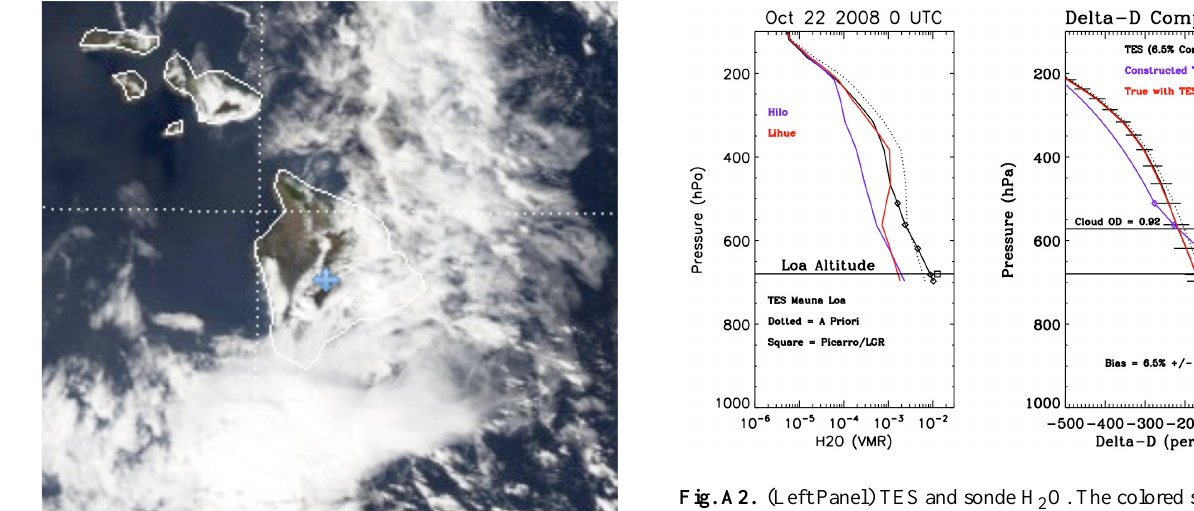
Fig. A2. (Left Panel) TES and sonde H 2 O. The colored solid lines show H 2 O measurements from sondes launched in Hilo and Lihue and modified by the TES H 2 O averaging kernel and a priori constraint (dotted line). Right Panel: The TES δ -D profile (corrected for bias), the a priori constraint (dotted line), the constructed “true” δ -D profile (solid blue line), and the “true” profile modified by the TES averaging kernel and a priori constraint (solid red line). The error bars are due to measurement and interfering geophysical parameters as well as errors in the constructed “true” profile. The cloud top height is the solid line. Diamonds in both plots refer to the pressure levels used to construct the “true” δ -D profile. The square in the left panel is the corresponding in situ measurement at the time of the TES overpass.